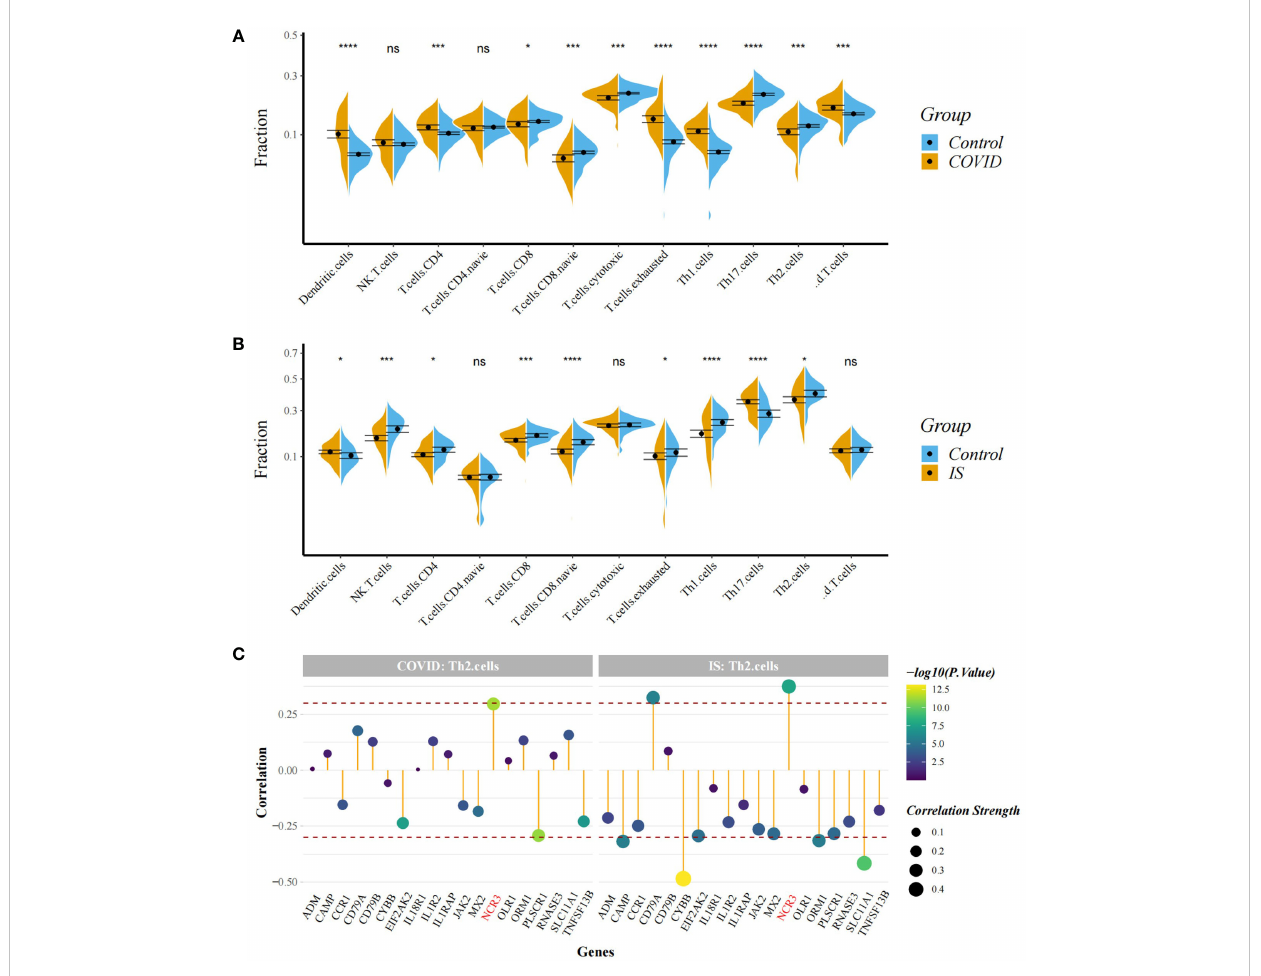
FIGURE 8 (A, B) Comparison of proportion of immune cells between COVID-19/IS and controls with t-test. Analyses were performed using ImmuneCellAI. *:P < 0.05; ***:P < 0.001; ****:P < 0.0001 (C) Spearman Correlation Analysis between gene expression of the common IDEGs and Th2 cell proportion. The red dashed lines represent +0.3 and -0.3. "ns" means P value > 0.05, representing no difference between the case and